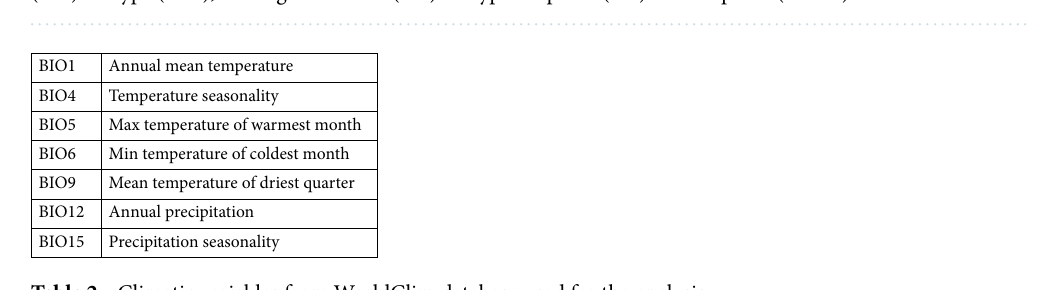
Table 2. Climatic variables from WorldClim database used for the